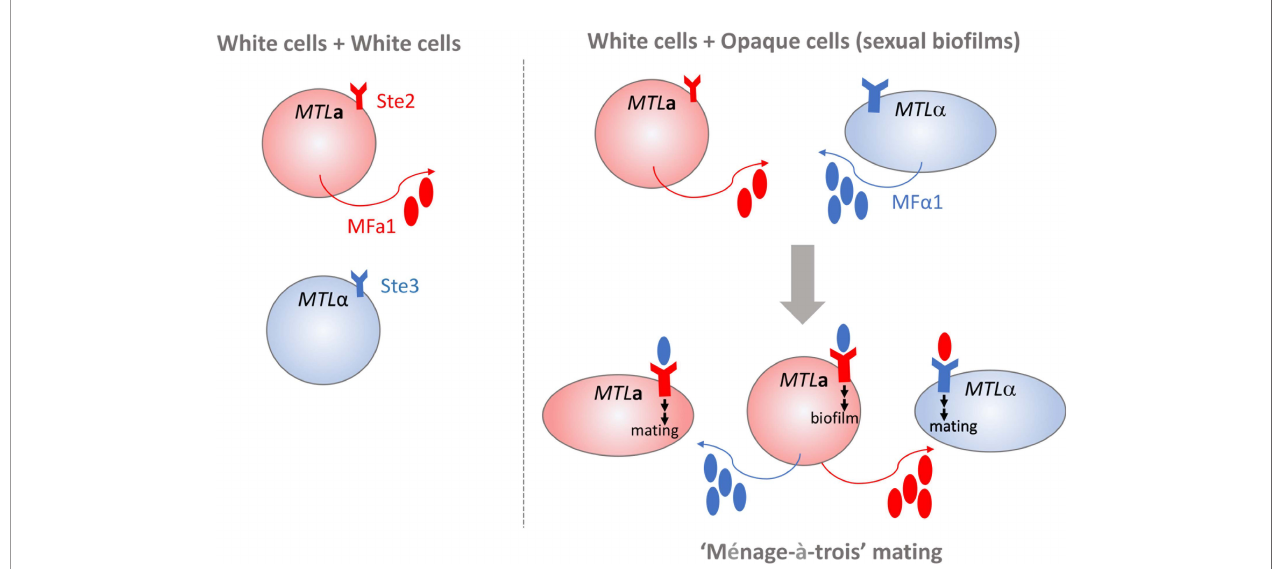
FIGURE 2 | White cells in C. albicans mating. White cells (depicted as spherical cells) of opposite mating types do not produce a mating response because of a lack of pheromone production and receptor engagement (shown on left). MTL a white cells exposed to high levels of MF a 1 can initiate formation of complex bio fi lm structures that support opaque cell mating (shown on right). Pheromone-stimulated MTL a white cells can also engage in “ me ́ nage-à-trois ” mating by supplying MF a 1 and MFa1 pheromones to both opaque MTL a and MTL a opaque cells (depicted as elongated cells) that induces polarized growth and cell